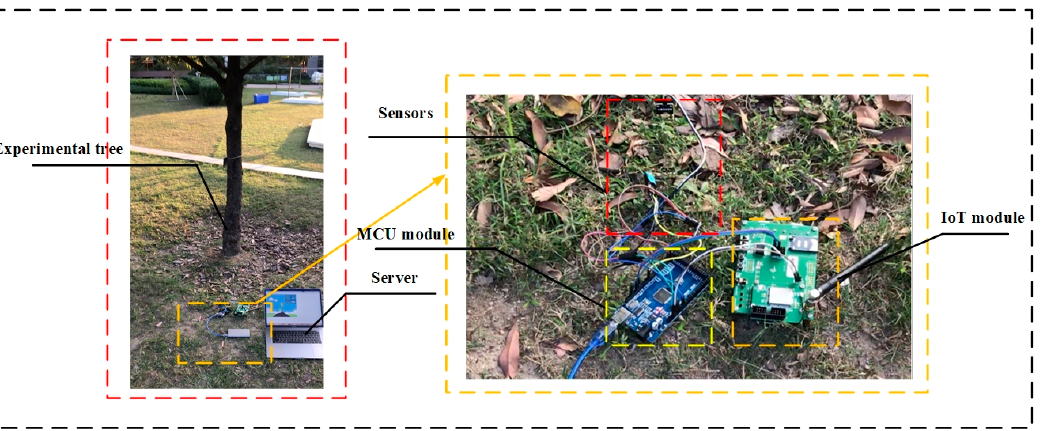
Figure 3. The distribution of test areas.